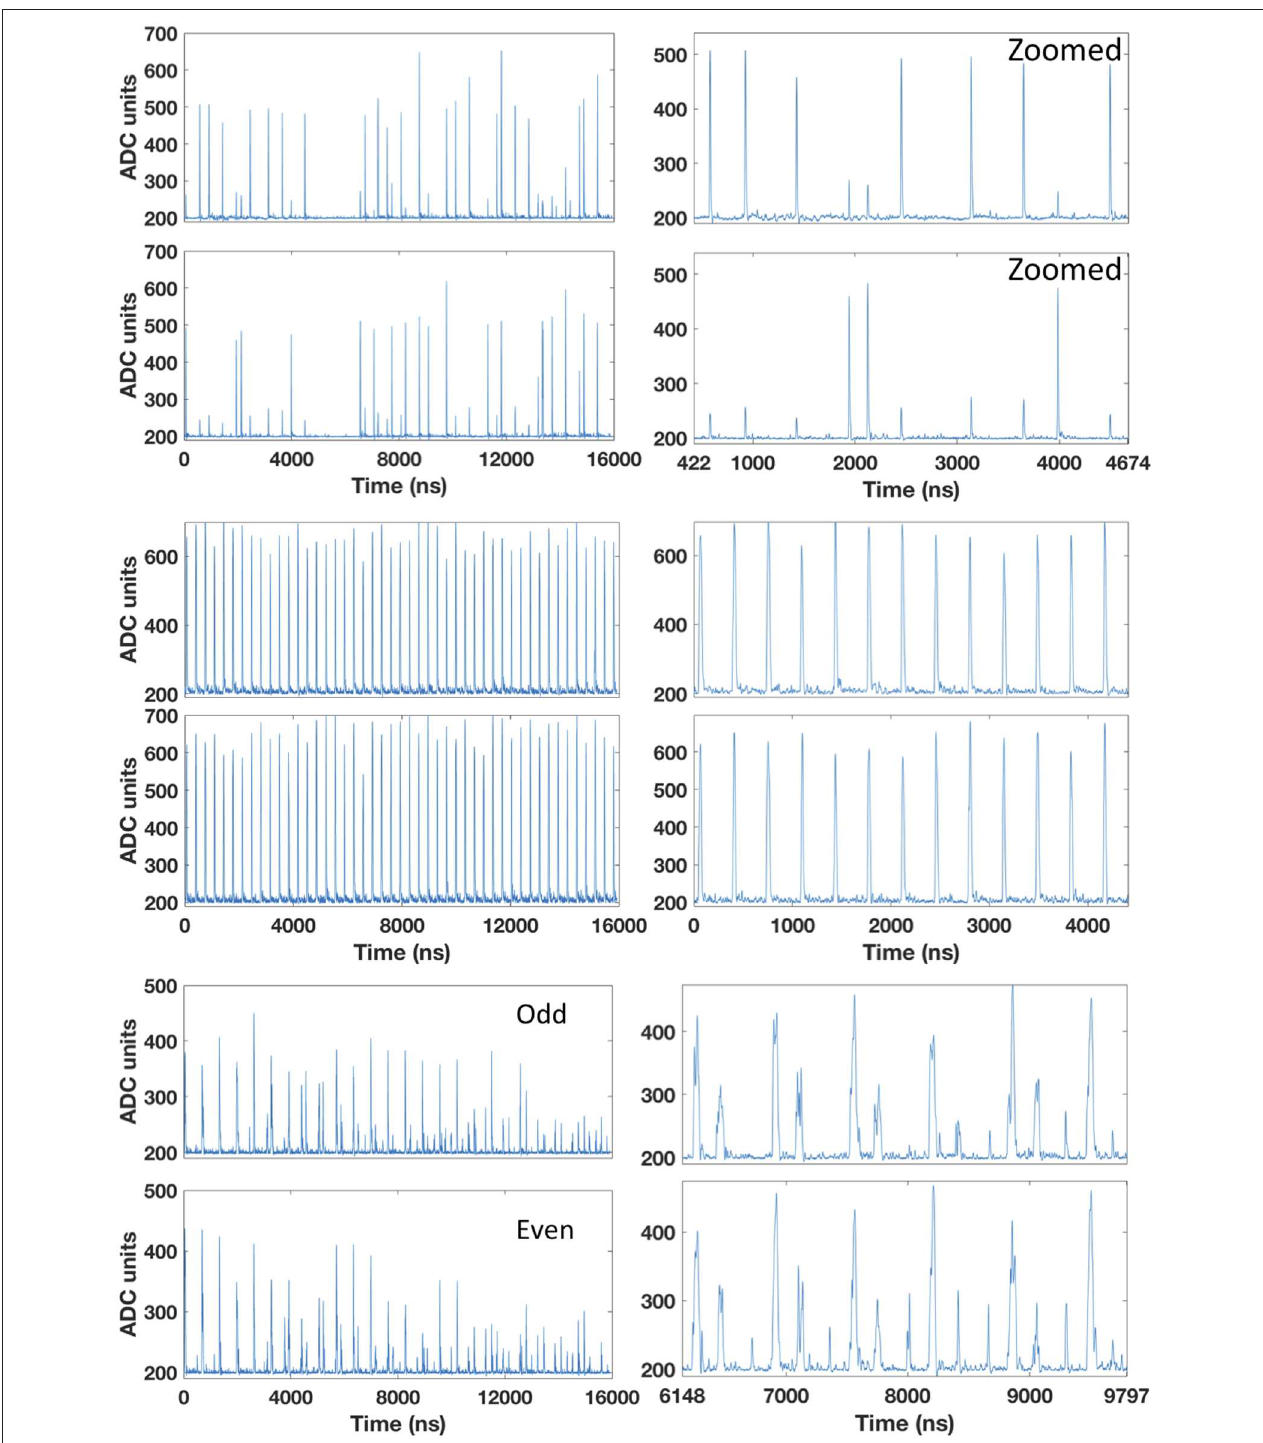
FIGURE 3 | Time microstructure for carbon (top) , helium (middle) , and proton (bottom) beams. The beam energies are 276, 146, and 145 MeV/u, respectively. The intensities are 2 × 10 6 , 2 × 10 7 , and 8 × 10 7 p/s, respectively. The trace duration is 16 µ s and hits in both odd and even fibers are shown. The right plots correspond to a windowed region from the left plot. Cross-talk for carbon ions and multiple hits for protons are clearly visible.